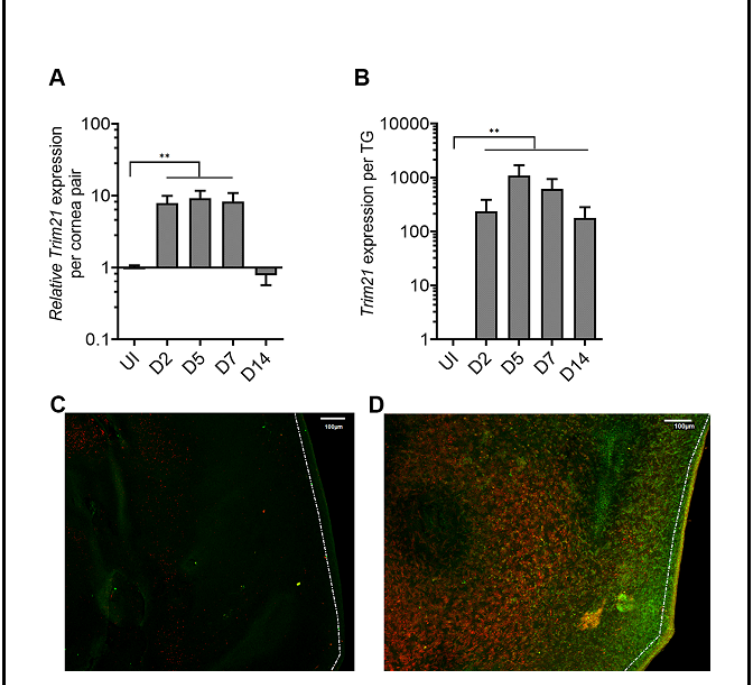
Figure 1. TRIM21 expression in the cornea and trigeminal ganglia. Male and female C57BL/6 (B6) mice were infected in the cornea with HSV-1 (10 3 plaque forming units (PFU) in 3 ul PBS. At the indicated time post infection (pi), the ( A ) corneas (5–7 samples/time point) or ( B ) trigeminal ganglia (TG) (3–5 samples/time point) of infected mice were removed and assessed for expression of TRIM21 by real-time RT-PCR. Bars represent the mean relative value + SEM, ** p < 0.01, comparing the indicated groups as determined by one-way ANOVA and Kruskal–Wallis multiple comparison test. Representative confocal images of ( C ) uninfected and ( D ) infected corneas stained for TRIM21 (red) and HSV-1 (green) antigen at 3 days post infection. Uninfected (UI) mice served as controls. The white scale bar = 100 µm.